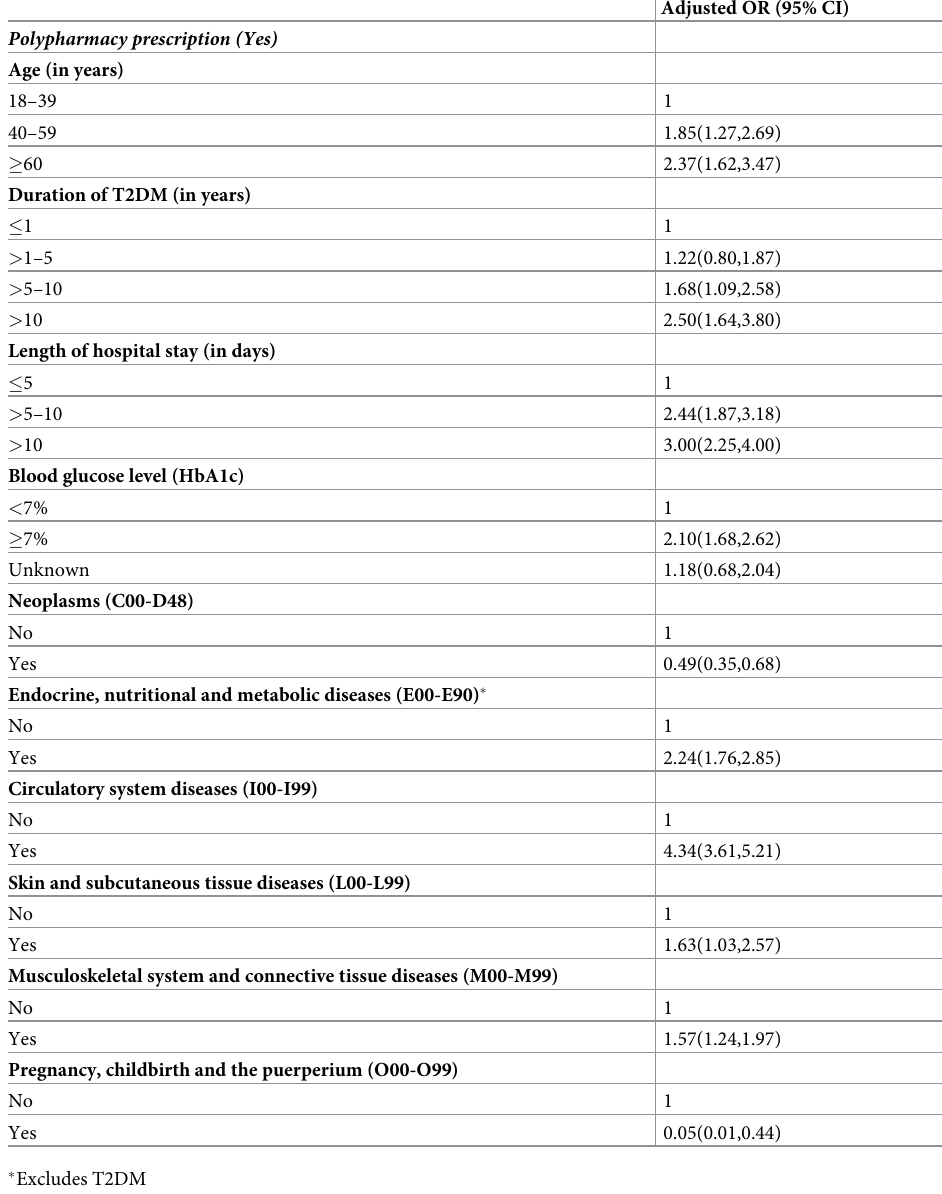
Table 4. Sensitivity analyses (multiple logistic regression models)—independent variables with p � 0.20 in simple logistic regressions were